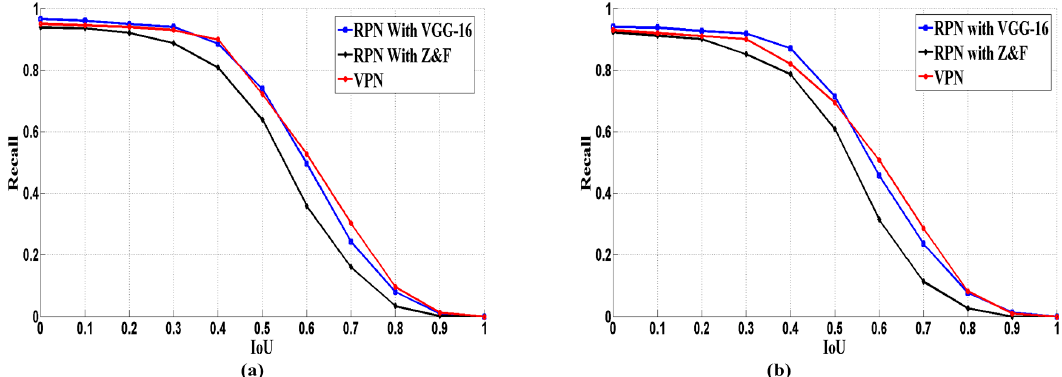
Figure 8. Recall vs. IoU curve of three CNN-based models: ( a ) VEDAI 1024 ( b ) VEDAI 512.